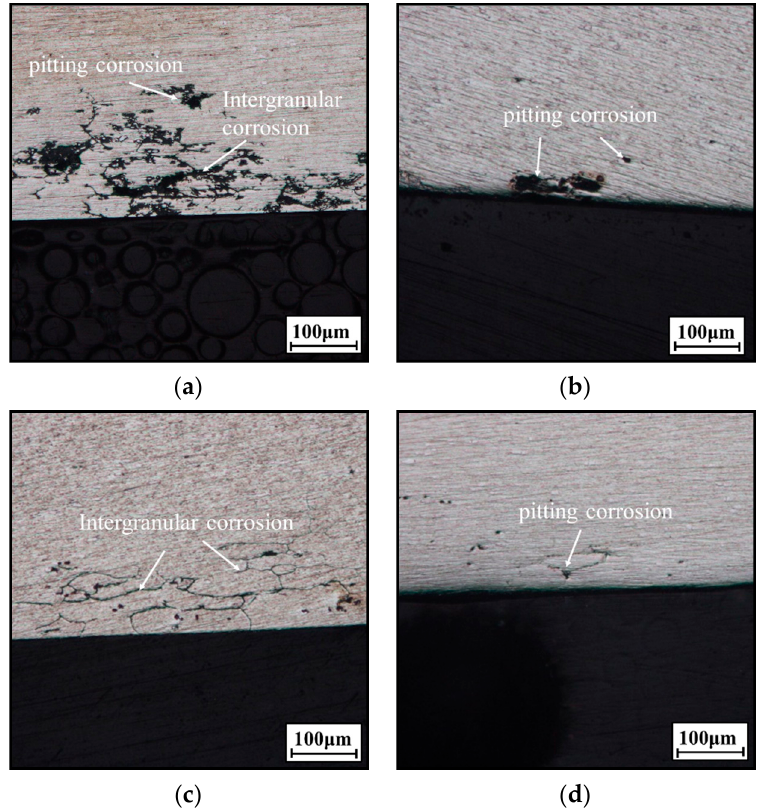
Figure 8. OM images of longitudinal section of the alloys at: ( a ) T = 155 °C, t = 6 h; ( b ) T = 155 °C, t = 24 h; ( c ) 175 °C, t = 6 h; ( d ) 175 °C, t = 24 h.